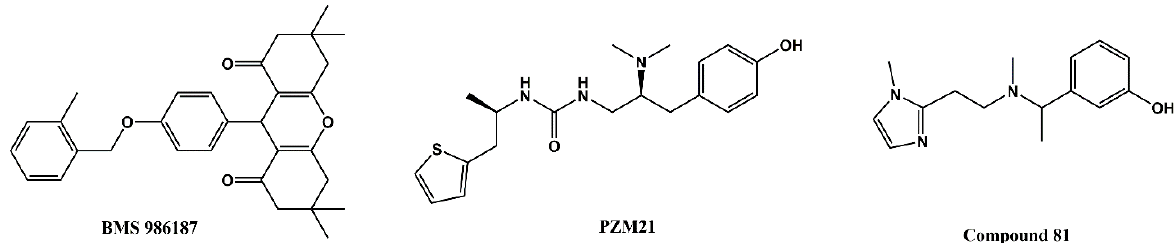
Figure 8. Chemical structures of the allosteric G-protein-biased δ OR modulator BMS 986187, the G-protein-biased µOR agonist PZM21 and the G-protein-biased κ OR agonist compound 81.